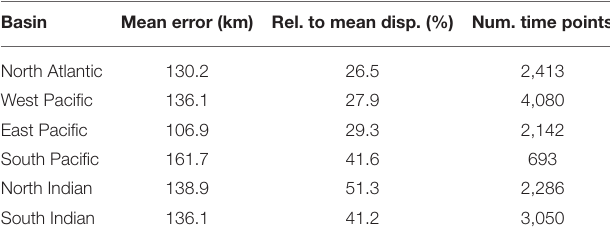
TABLE 4 | 24 h-forecast results for the different regions (basins), on the test set. Basin